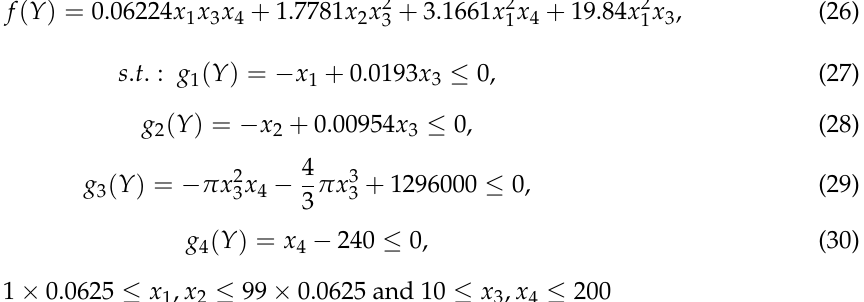
Figure 7. The Pressure Vessel Design Problem. During the last few decades, several researchers have used different types of metaheuristics to find the best possible optimal solutions of the Pressure Vessel Design Problem in the literature such as Genetic Algorithm (GA) [50–52], Artificial Bee Colony algorithm (ABC) [54], Co ‐ evolutionary Differential Evolution (CDE) [55], Co ‐ evolutionary Particle Swarm Optimization (CPSO) [56], Improved Harmony Search (IHS) algorithm [57], Moth ‐ Flame Optimization algorithm (MFO) [33],